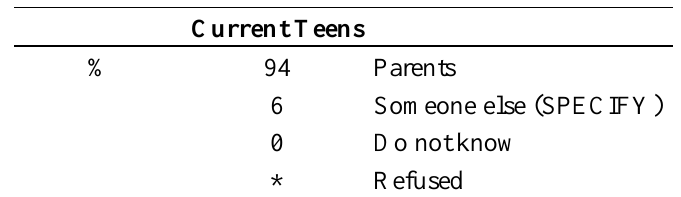
Table A10. K43 Who pays [the costs/the other part of the costs] of your cell phone? Is it your parents or someone else? ( Based on teen cell users who do not pay all the costs of their cell phone [ N = 566]